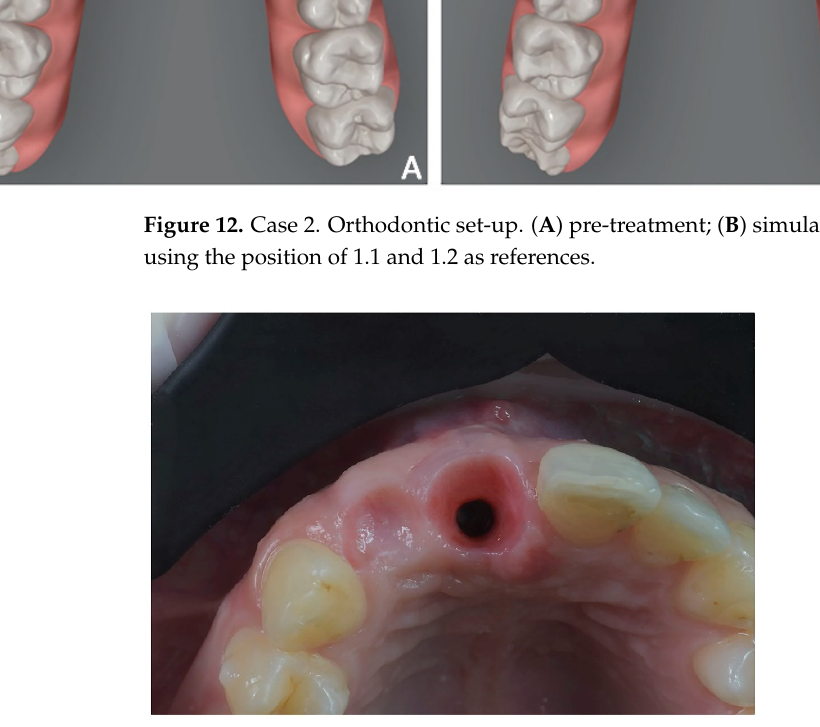
Figure 14. Case 2. Final prosthesis using milled cobalt-chrome structure and feldspathic porcelain. ( A ) Milled cobalt-chrome structure; ( B ) radiographic evaluation; ( C ) prosthesis veneered with feldspathic porcelain.